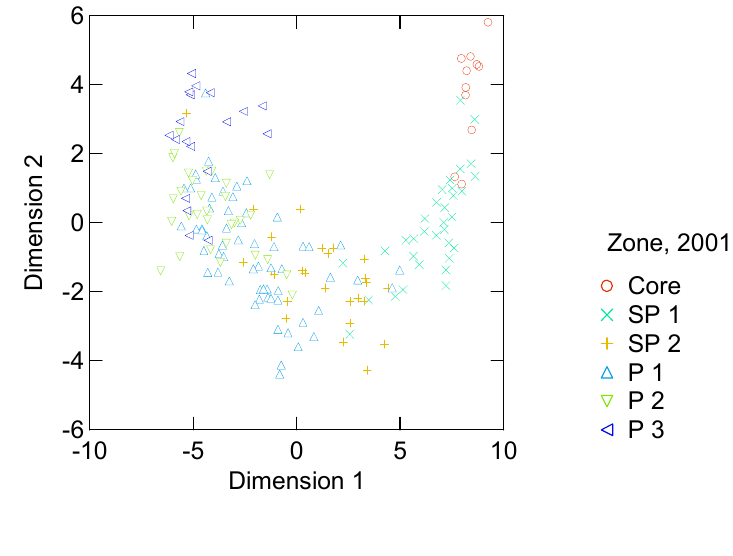
Figure 5: Exponential Distance Model with Hierarchical Clustering of Regular Equivalencies Superimposed,